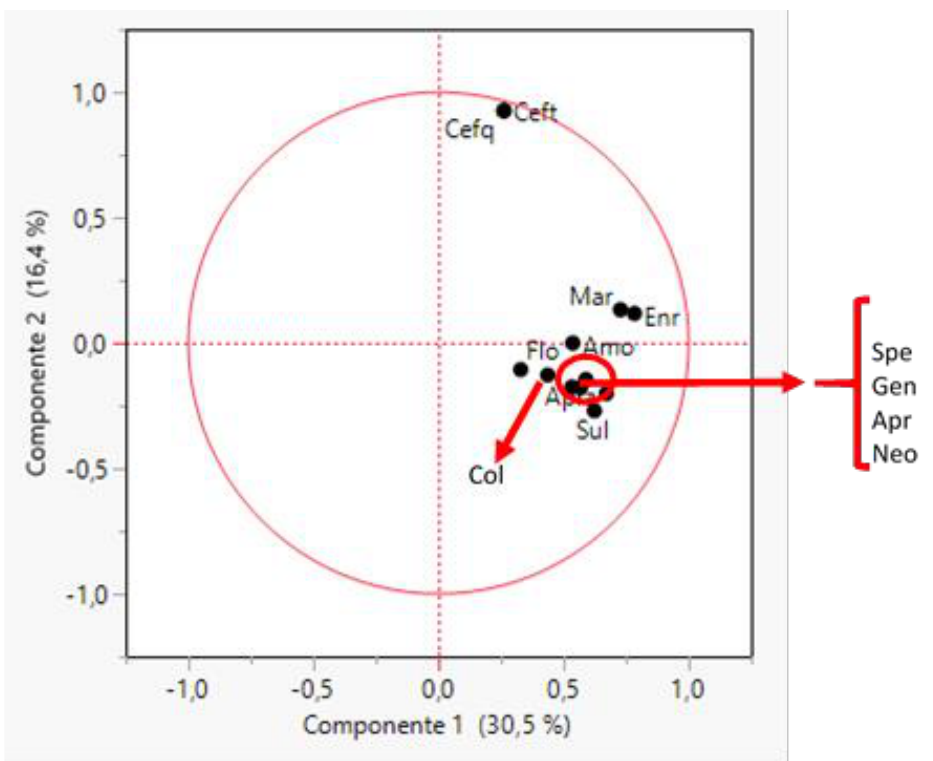
Figure 5. Biplot obtained through a principal component analysis of MIC values for twelve antimicrobials and 1571 strains of Escherichia coli (EC). The antimicrobials tested were amoxicillin (Amo), apramycin (Apr), cefquinome (Cefq), ceftiofur (Ceft), colistin (Col), enrofloxacin (Enr), florfenicol (flo), gentamycin (Gen), marbofloxacin (Mar), neomycin (Neo), spectinomycin (Spe) and sulfamethoxazole/trimethoprim (Sul).